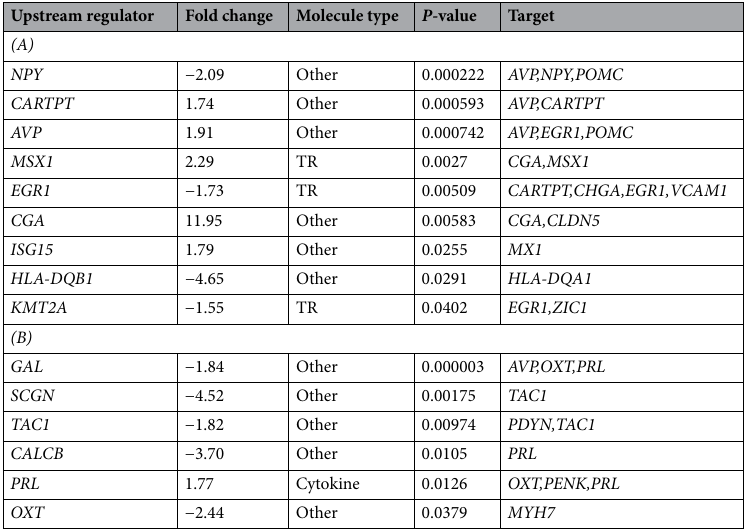
Table 2. Upstream regulators controlling the expression of differentially expressed genes (DEGs) in the arcuate nucleus (A) and the remaining hypothalamic tissue (B) of heifer calves on high vs moderate planes of nutrition that are included in the list of those DEGs. TR = transcription